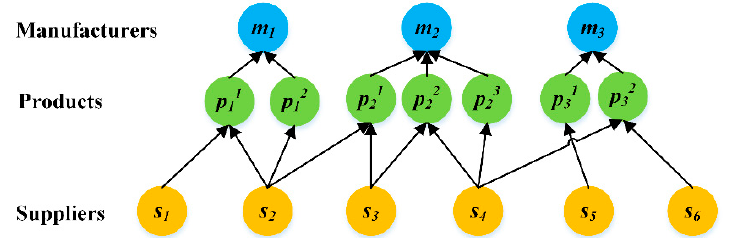
Figure 1. Tripartite graph-based supply network model.